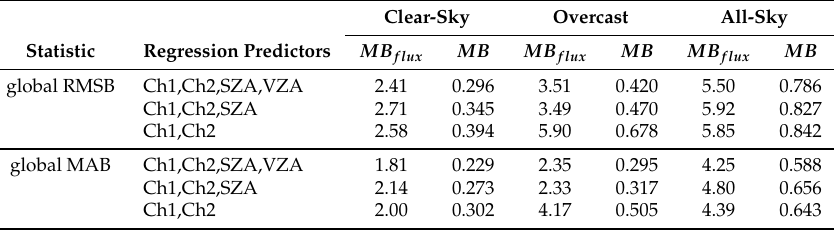
Table A3. Global accuracy statistics from bias map, based on surface-type-independent regressions from expanded database (with relaxed matching criteria) for clear, overcast, and allsky conditions; Data: 2004–2005 (NOAA17+Terra), 2007–2008 (NOAA18+Aqua) and 2011–2012 (NOAA19+Aqua). Clear-Sky Overcast All-Sky